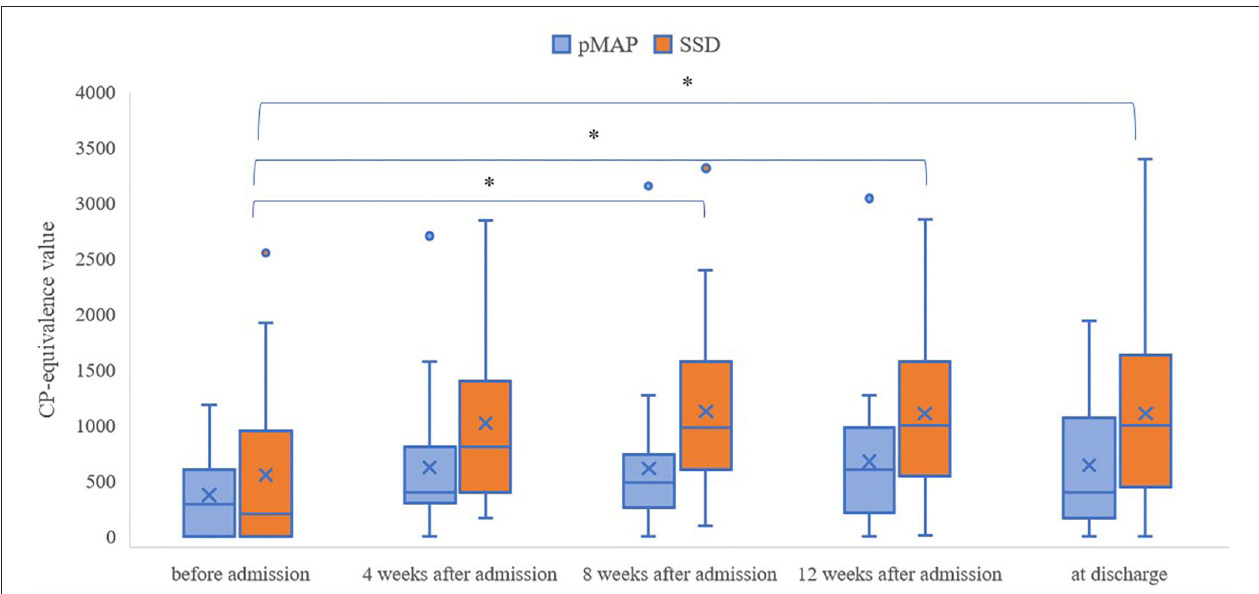
FIGURE 1 | Changes in CP-equivalence value over time within the pMAP and SSD groups. Friedman test: p = 0.0003 in the SSD group, p = 0.337 in the pMAPgroup. Comparisons between time points were performed using Scheffe’s post hoc test. pMAP, persistent methamphetamine-associated psychosis; SSD, schizophrenia spectrum disorders; CP, chlorpromazine. * p <